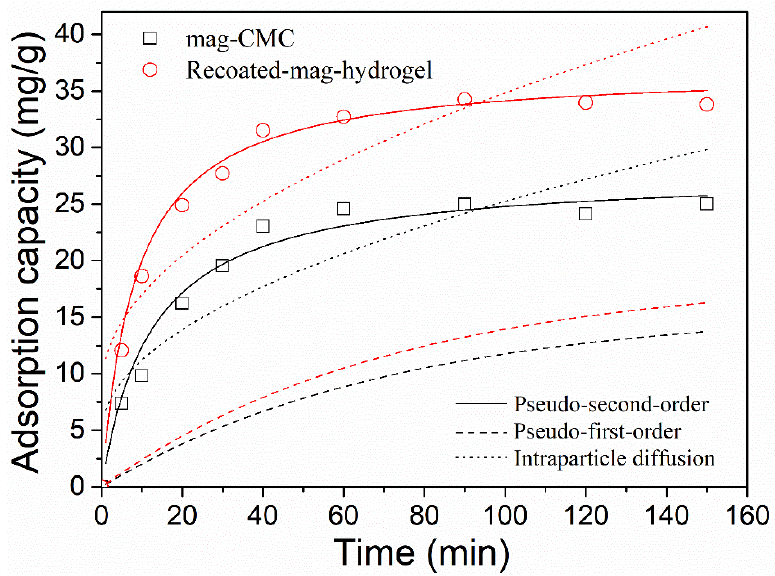
Figure 11. Effect of contact time on MB adsorption onto magnetic nanocomposites and fit curves of adsorption data by kinetic models.